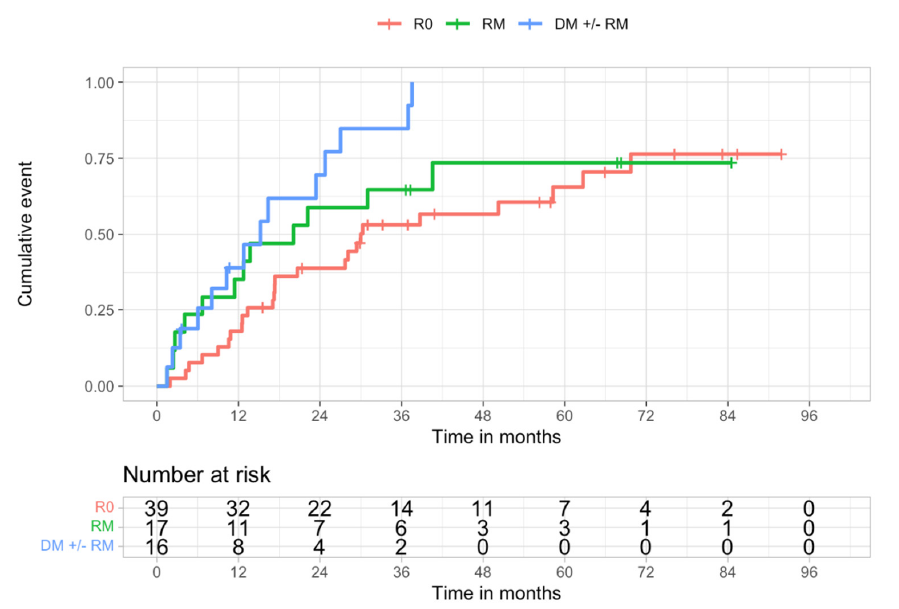
Figure 3. Kaplan-Meier recurrence curves of R0, RM, and DM ± RM populations (log-rank test, p = 0.0066).